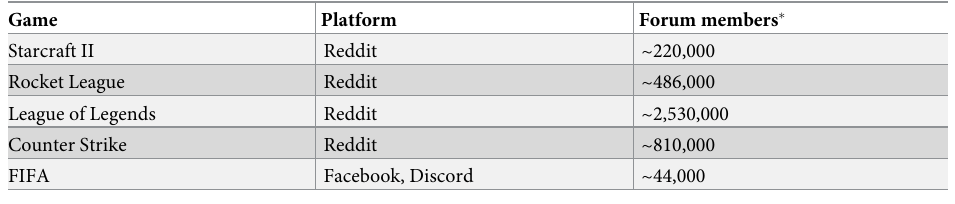
Table 10. Forum members for the esport games selected for this